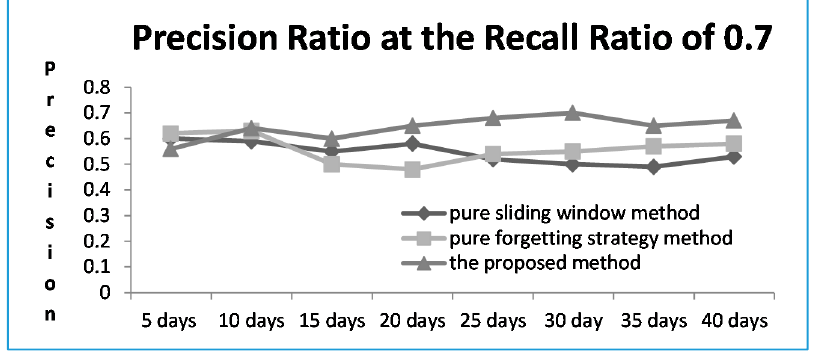
Figure 7. The precision ratio of the proposed method at the recall ratio of 0.7.